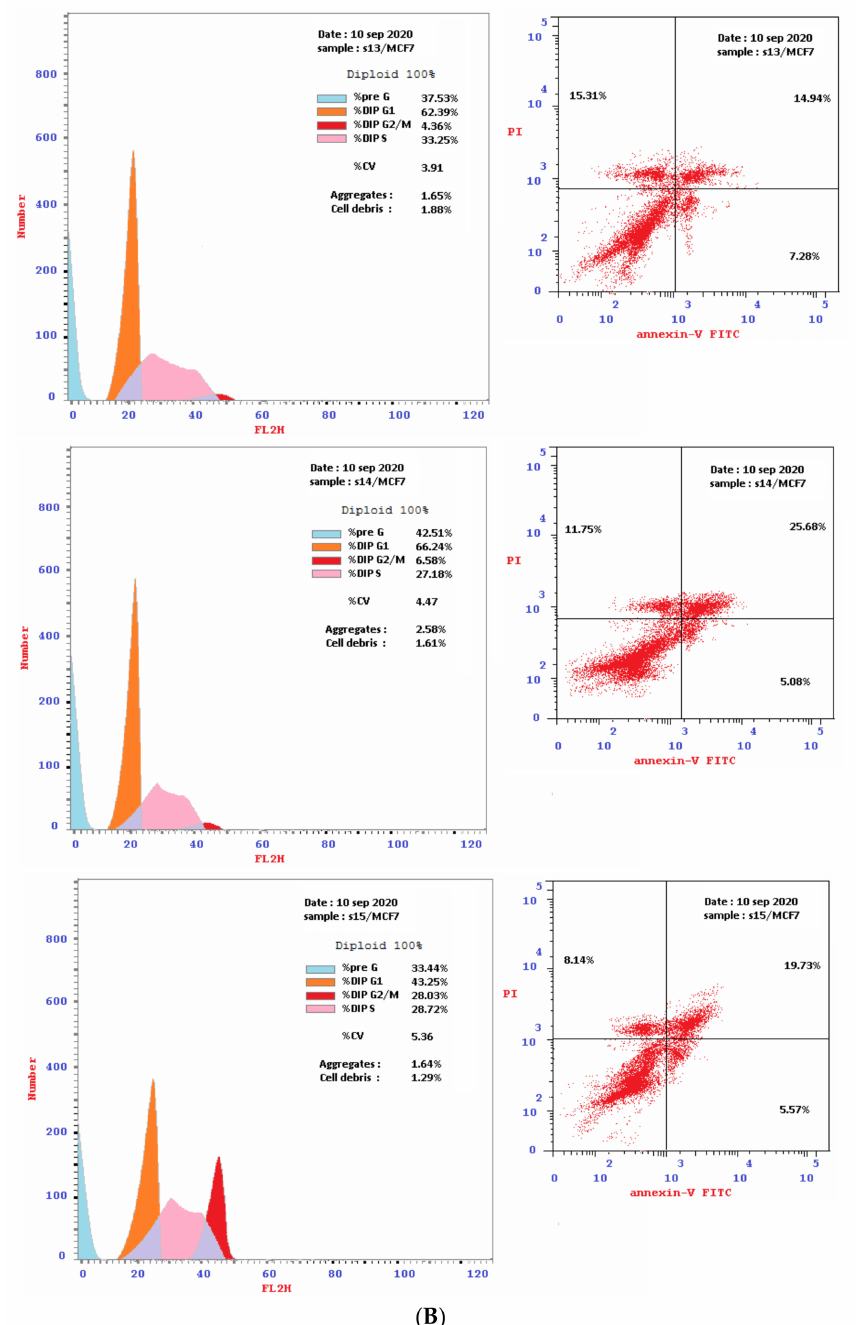
Figure 2. ( A ): The flow cytometry cancer cell cycle distribution (Left) and apoptotic status (Right) for MCF-7 and HepG2 cancer cells. Monolayer of cells was treated separately, for 48 h with DMSO or the IC 50 of compound 10 . ( B ): The flow cytometry cancer cell cycle distribution (Left) and apoptotic status (Right) for MCF-7 breast cancer cells. Monolayer cells of MCF-7 were treated separately, for 48 h with the IC 50 of compounds 13 , 14 and 15